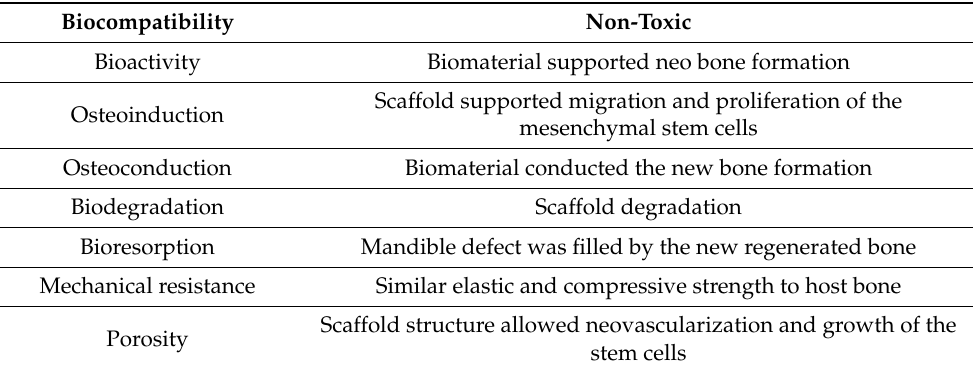
Table 1. The properties of ceramic biomaterial (hydroxyapatite plate) used in our